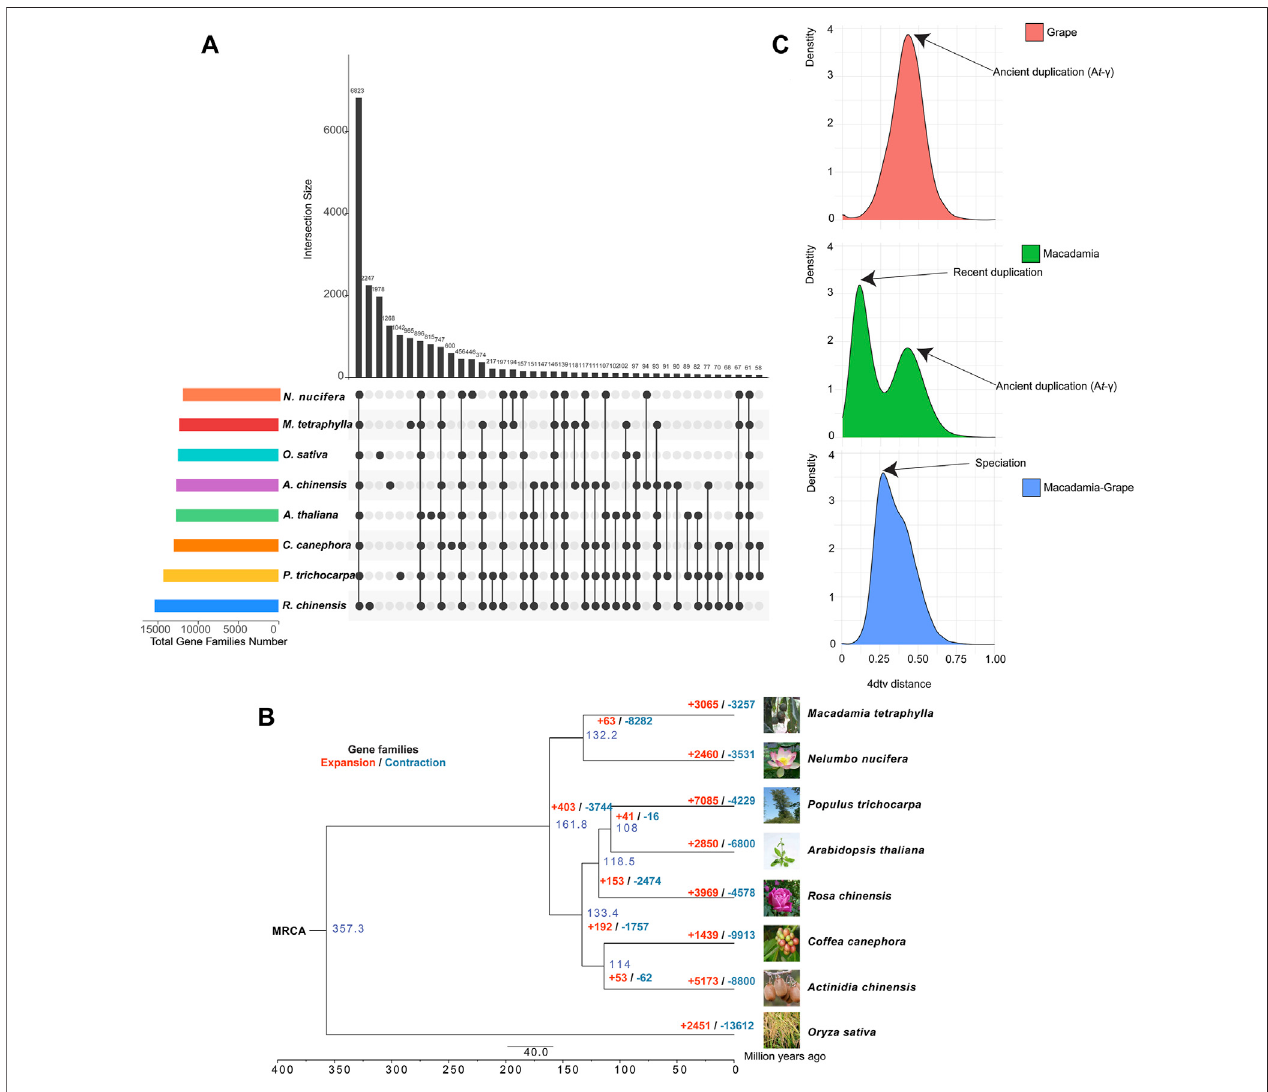
FIGURE 2 | Evolution of macadimia genome. (A) Venn diagram showing shared and unique gene families among macadimia and other plant species. (B) Comparative genomic analysis of macadimia and other plant species. (C) Distribution of 4DTv for pairs of syntenic paralogs.